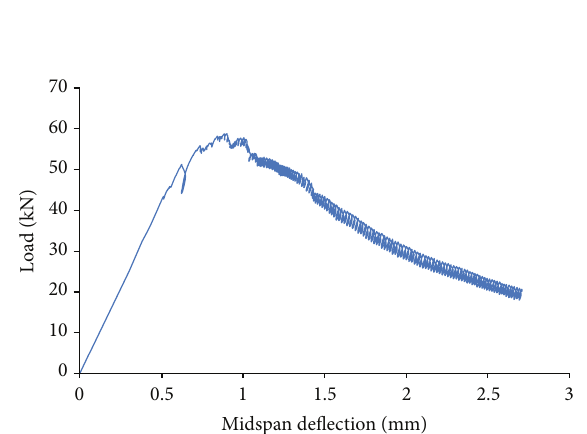
Figure 3: Flexural load-deflection curve of